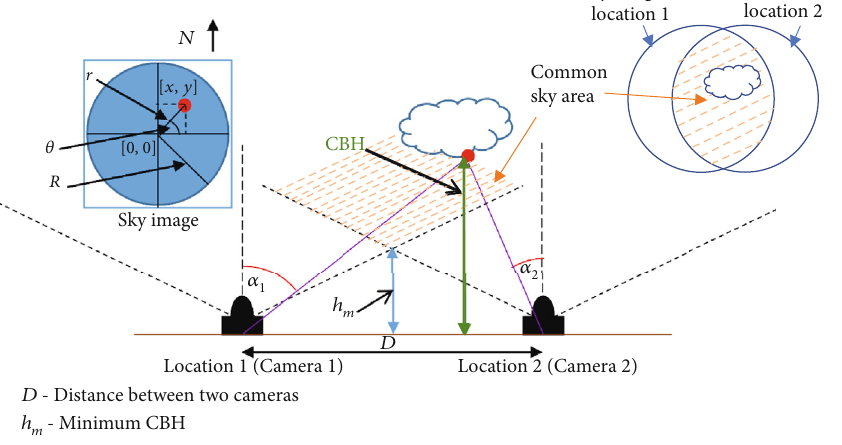
Figure 3: Placement of two cameras for CBH calculation and representation of a sample point in the cloud to the sky